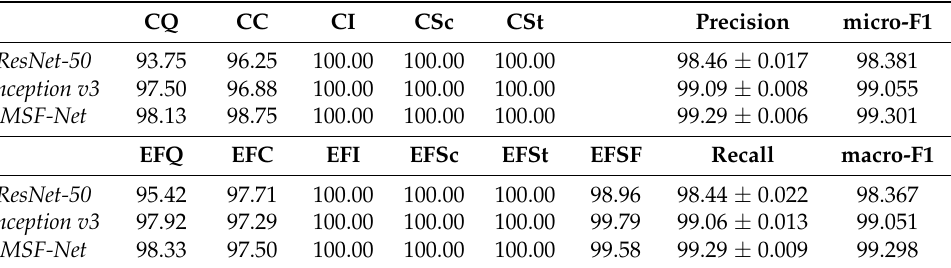
Table 7. Classification performance of three CNNs on the surface defect data set of roller (%).